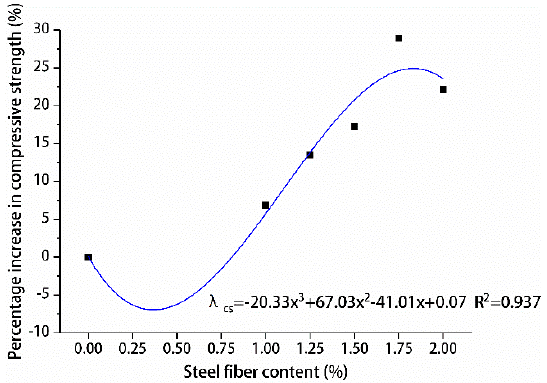
Figure 23. Relationship between compressive strength and steel fiber content.